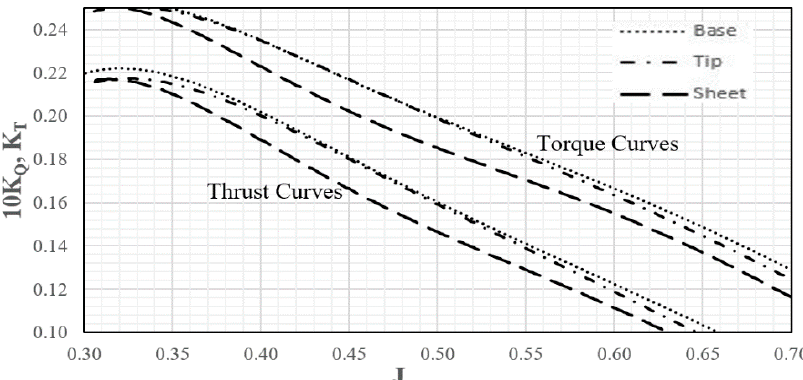
Figure 3. Comparative non-dimensional thrust and torque coefficients in open water and cavitation condition. Reproduced from [13] with permission from Newcastle University.